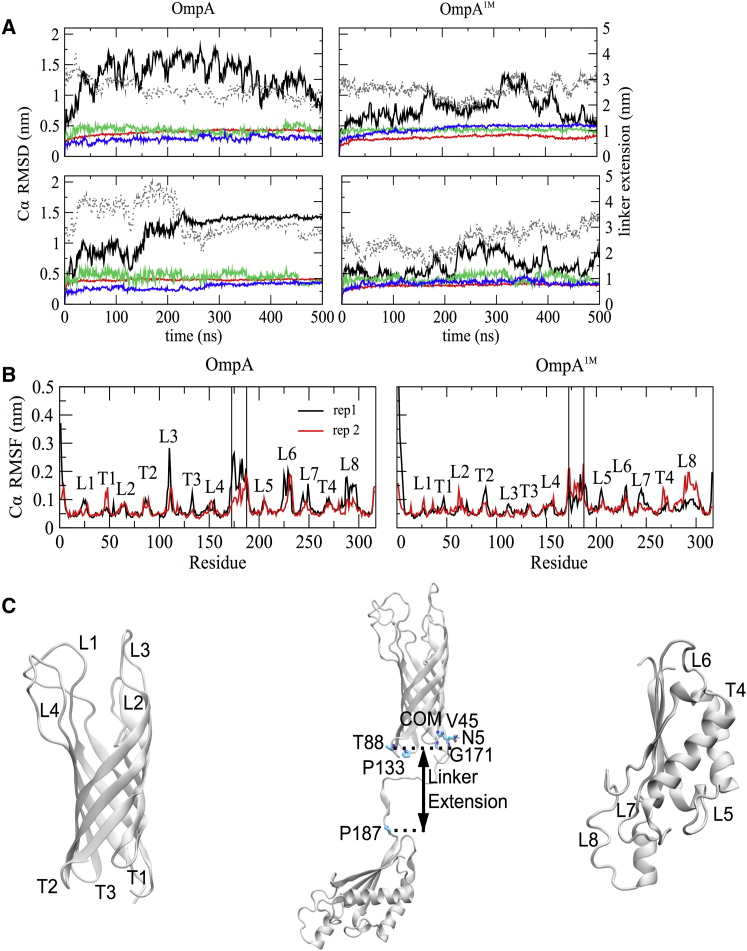
OmpA structural stability. (A) Cα RMSD of the overall protein and separate domains at low and 1 M ionic strengths compared with the extension of the linker region, as labeled in the inset. Results are shown for the least stable chain in each simulation replica. The different curves show data for the full protein (black), linker extension (black dashed), NTD (red), linker (green), and CTD (blue). A similar analysis for the monomer simulation is provided in Fig. S1. (B) Per-residue Cα RMSF of OmpA. For clarity, only the least stable chain is shown. Vertical lines represent domain boundaries. Fitting was done for each individual domain. (C) The structure of a full-length OmpA chain from E. coli is shown in cartoon format, showcasing three distinct domains: the transmembrane eight-stranded β-barrel NTD (left), a disordered linker, and a peptidoglycan-binding CTD (right). The linker extension was calculated as the center-of-mass distance between the periplasmic side of the NTD barrel, comprised of residues N5, V45, T88, P133, and G171, and the start of the CTD, namely, residue P187 (center). To see this figure in color, go online.